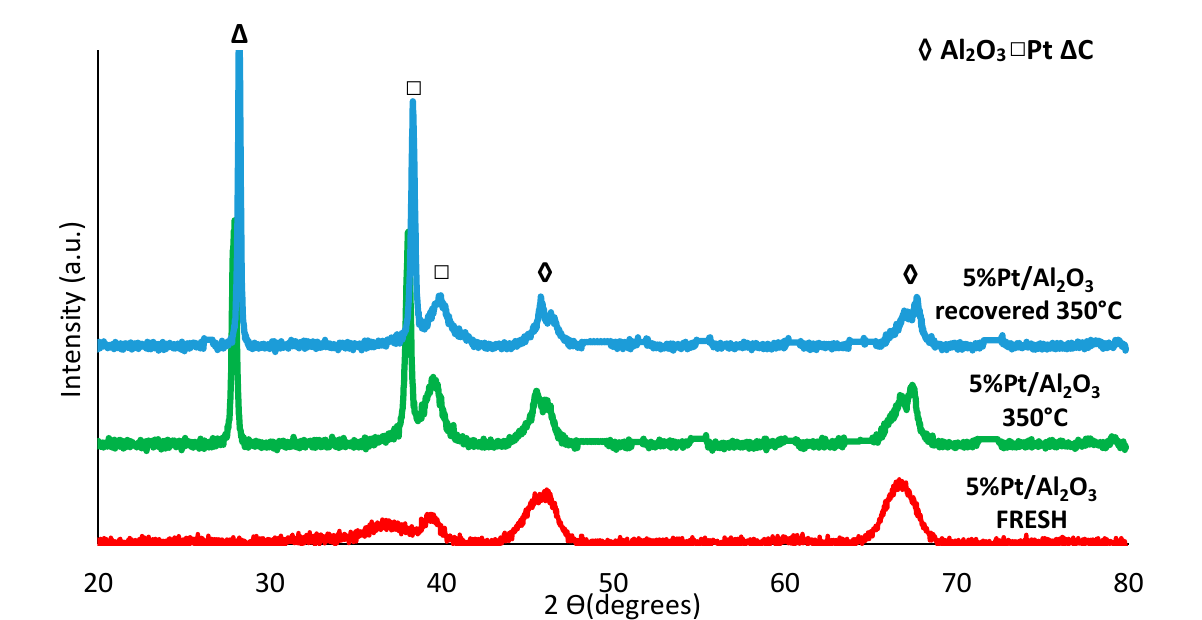
Figure 14. XRD of the fresh, tested (1st cycle) and recovered (2nd cycle) Pt/Al 2 O 3 .